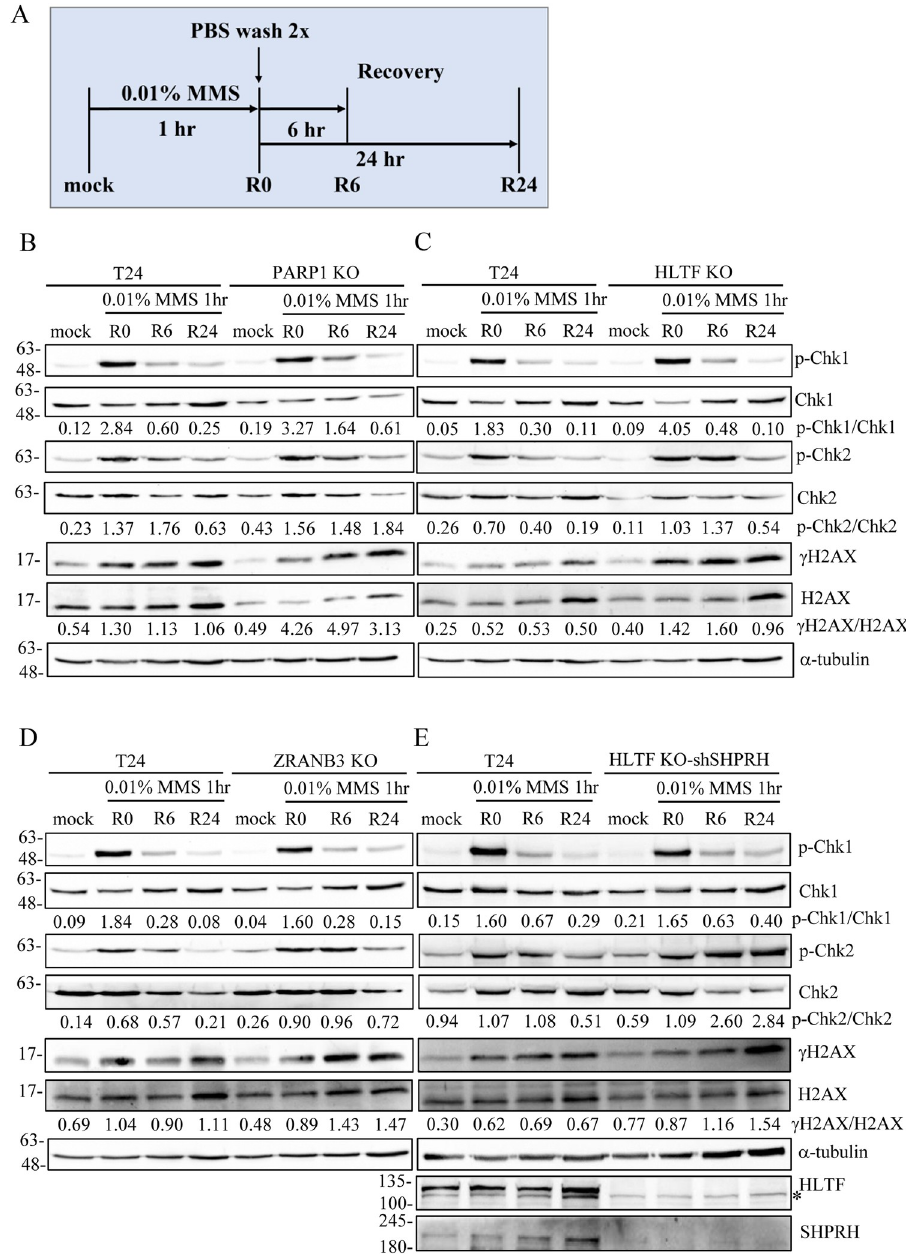
Fig 8. PARP1-, HLTF-, and ZRANB3-depleted cells show higher levels of γ H2AX and checkpoint activation than control cells after MMS treatment. (A) The protocol of DNA damage recovery assay. Cells were treated with 0.01% MMS for 1 hour (R0), followed by recovery in fresh medium for 6 (R6) and 24 (R24) hours. Cells were fixed and immunostained with antibodies as indicated. (B)-(E) Immunostaining of DNA damage recovery assay. Proteins were detected with specific antibodies as indicated. Asterisk ( � ) indicates non-specific